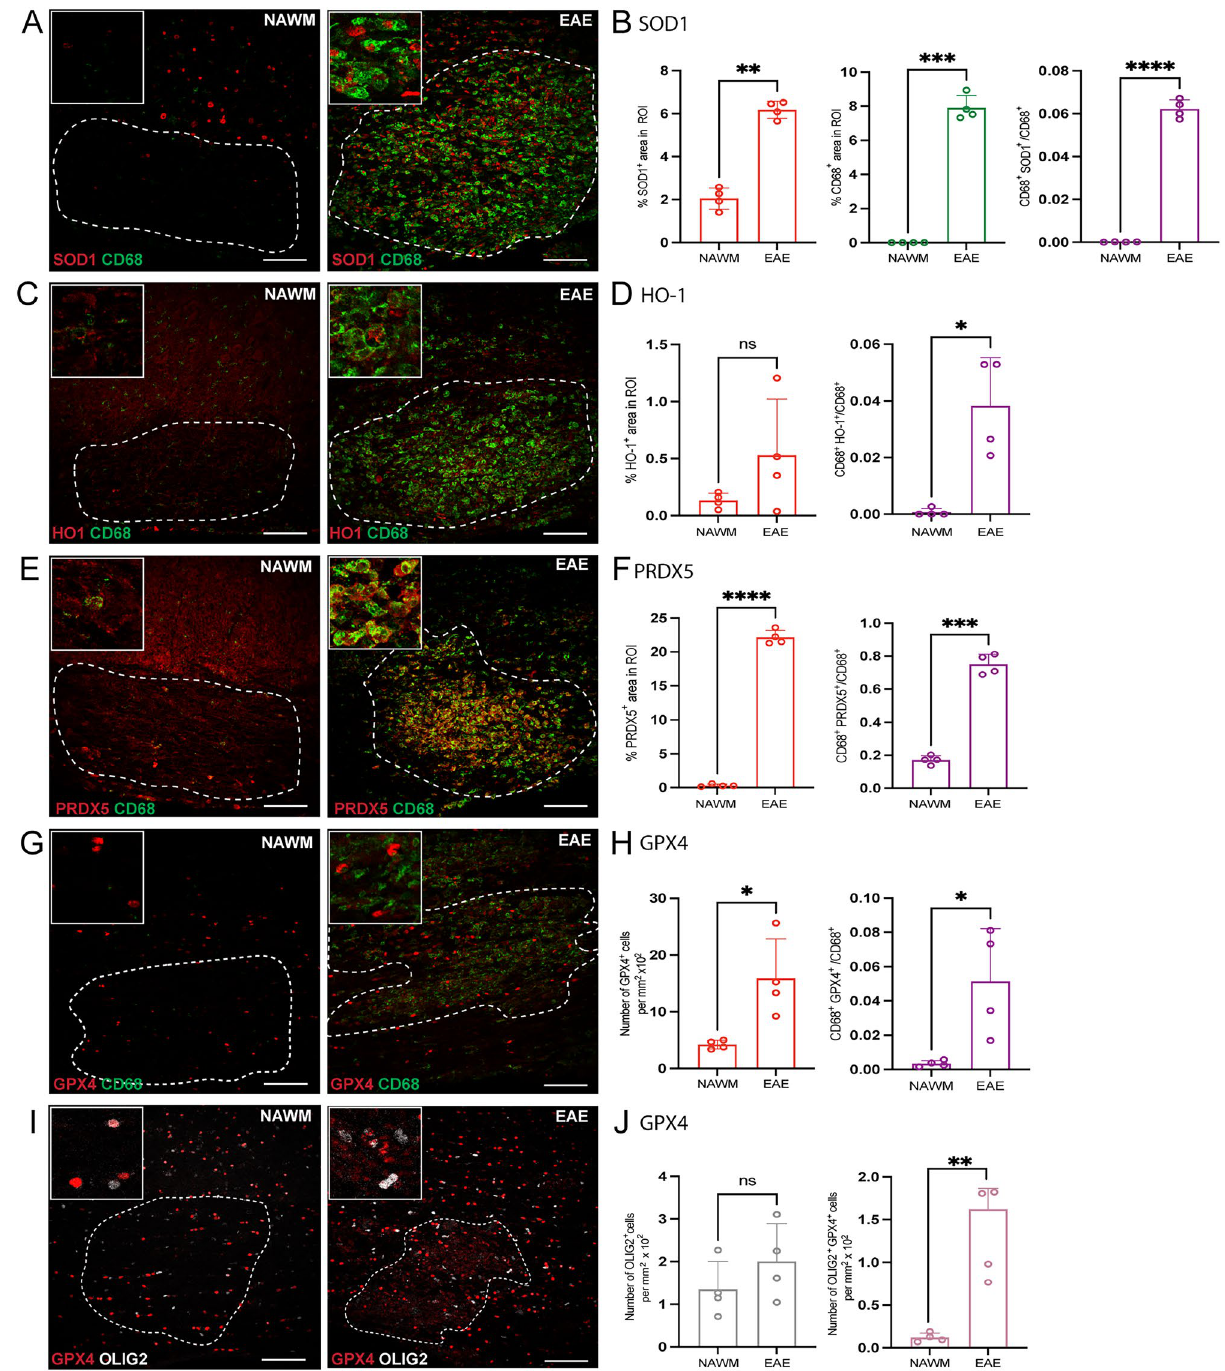
Figure 4. Detection of antioxidant enzymes is increased in EAE-induced lesions. ( A , C , E , G , I ) Representative confocal images of NAWM or EAE-induced mice labeled with CD68 for microglia/macrophage (green), antioxidant enzyme of interest (red), OLIG2 for oligodendrocyte lineage cells (white). Dotted line indicates the lesion ROI selected for image analysis. ( B , D , F ) Bar graphs comparing the percent of ROI that is CD68 + , antioxidant enzyme of interest, and CD68 + antioxidant enzyme + . ( H ) Bar graph comparing the number of GPX4 + cells per mm 2 × 10 2 of ROI and percent of ROI that is CD68 + GPX4 + ( J ) Bar graph representing number of OLIG2 + cells per mm 2 × 10 2 of ROI and percent of ROI that is OLIG2 + GPX4 + . Scale bar = 100 µm. Data are shown as mean ± S.D, n = 4 mice. Significance indicated as * p < 0.05, ** p < 0.01, *** p < 0.001, **** p < 0.0001, two- tailed, paired student’s